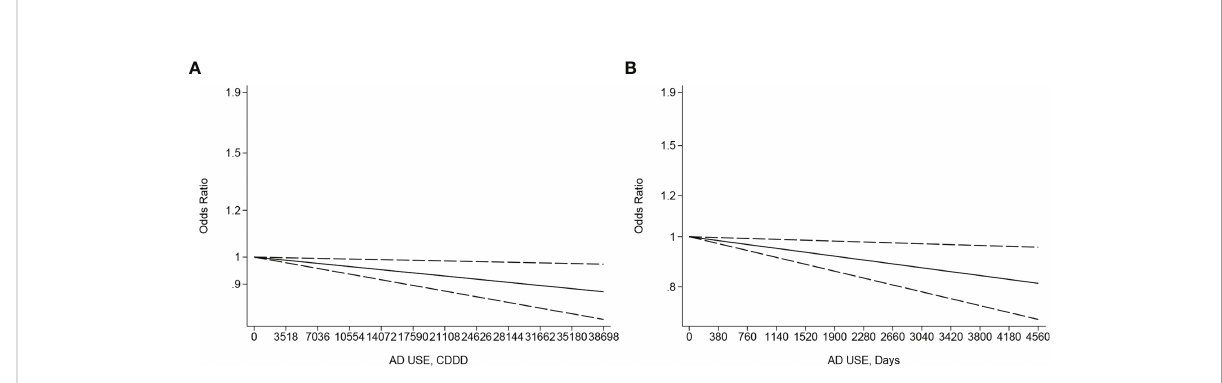
FIGURE 4 (A) Dose – response for CDDD of antidepressant use and incidence risk of ovarian, endometrial, and cervical cancer. (B) Dose – response for duration of antidepressant use and incidence risk of ovarian, endometrial, and cervical cancer. The black solid line and the black long dashed line represent the estimated odds ratios (ORs) with corresponding 95% con fi dence intervals (CIs) for the non-linearity or the